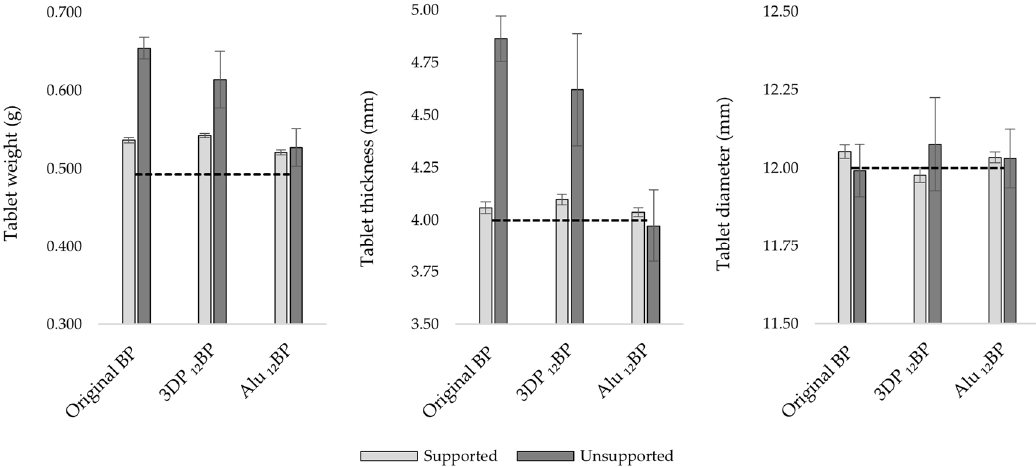
Figure 9. Tablet uniformity of weight ( left ), thickness ( middle ), and diameter ( right ). Black and white bars represent data from tablets printed with and without supports, respectively. Black dashed lines indicate the theoretical value for each parameter. Results were expressed as average ( n = 30). Error bars indicate standard deviation.